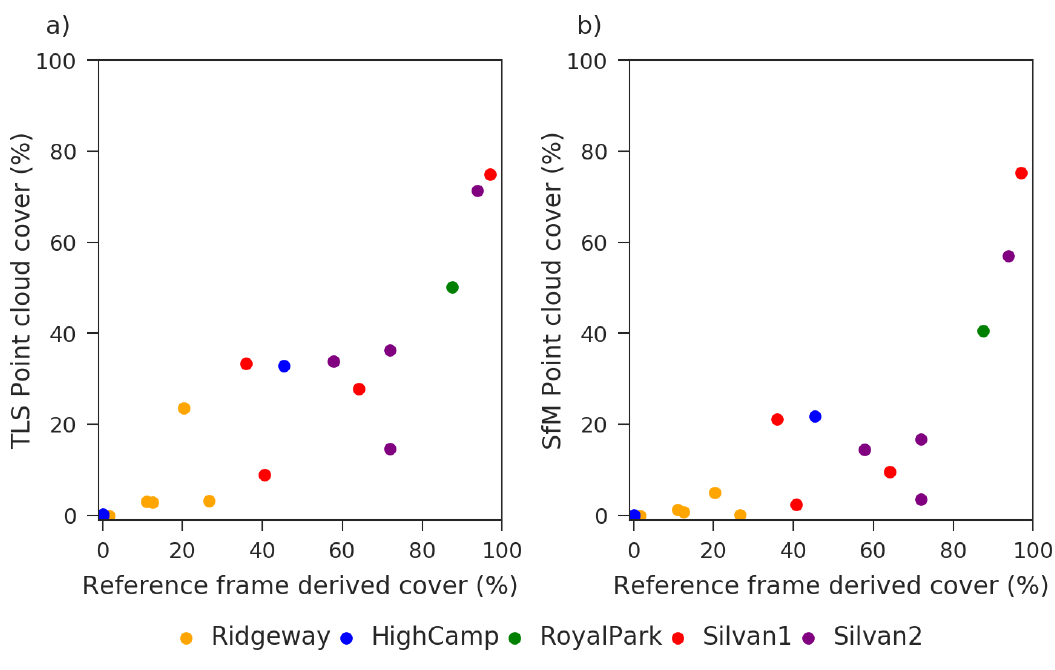
Figure 8. TLS ( a ); and SfM ( b ) point cloud cover compared to cover derived from reference frame measurements.